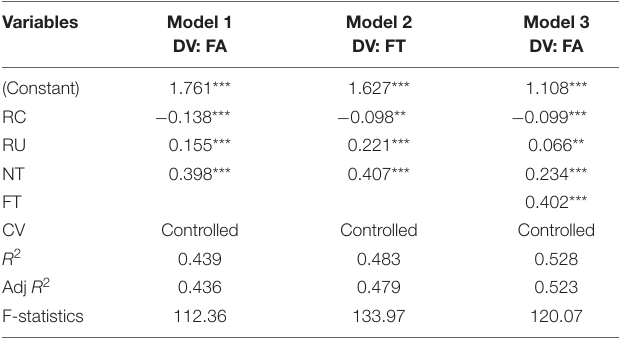
TABLE 3 | Estimation results of the mediation effect model. Variables Model 1 DV: